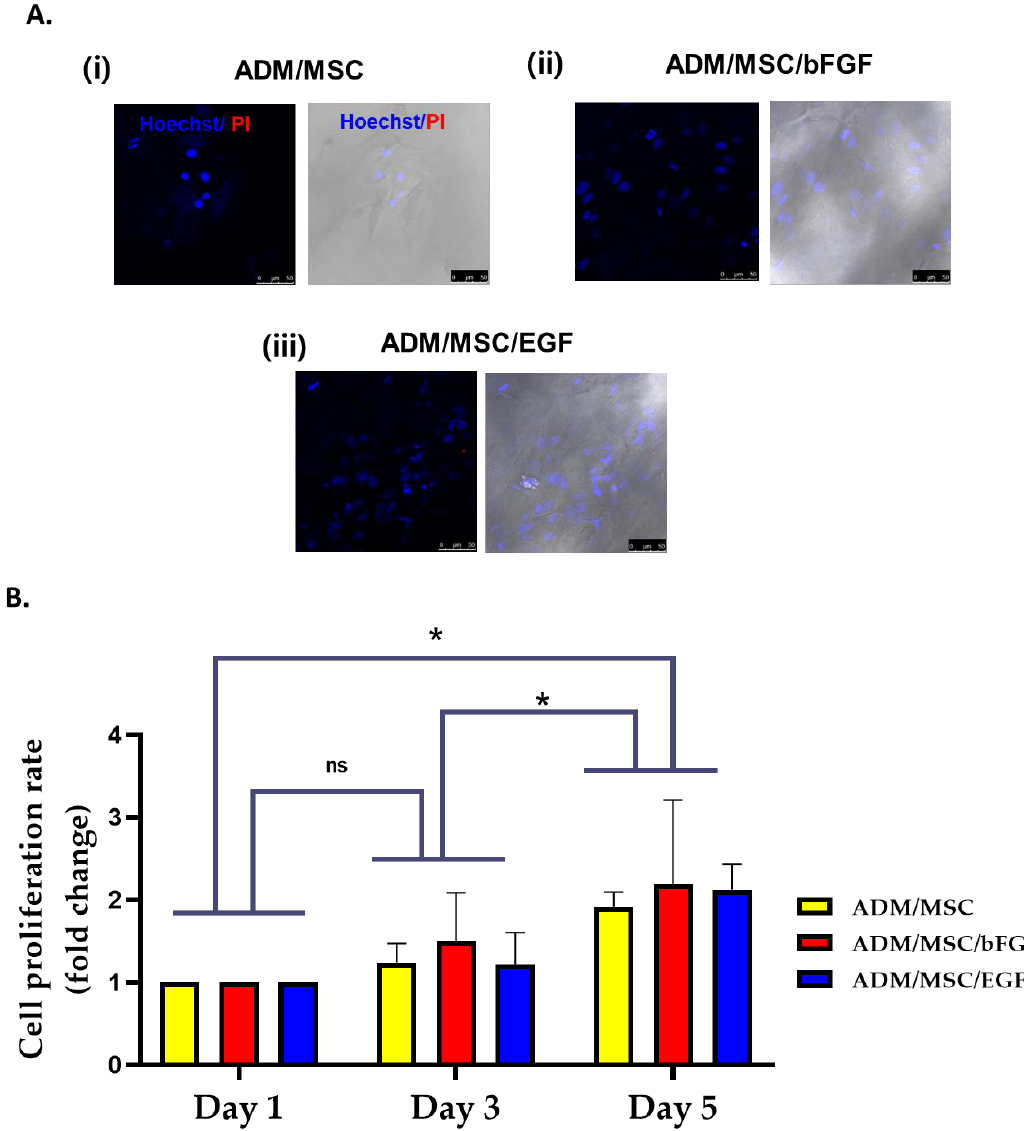
Figure 2. ( A ) Live and dead cell staining of hBM-MSCs on acellular dermis observed under confocal microscope. Increased number of cells was observed in each group treated with (ii) basic fibroblast growth factor (bFGF) and (iii) epidermal growth factor (EGF), than in the (i) control group. ( B ) The proliferation rate of hBM-MSCs through MTT assay was confirmed after 1st, 3rd and 5th days culture. Number of cells were increased the most in AC/MSCs/EGF group. Cell proliferation was increased in a time-dependent manner in all the groups. ( n = 3). Significant difference in the proliferation rate was not observed between Day1 and Day3, but there was a significant change in the fold change between Day1/Day5 and Day3/Day5 (* p < 0.05); ns = non significant.